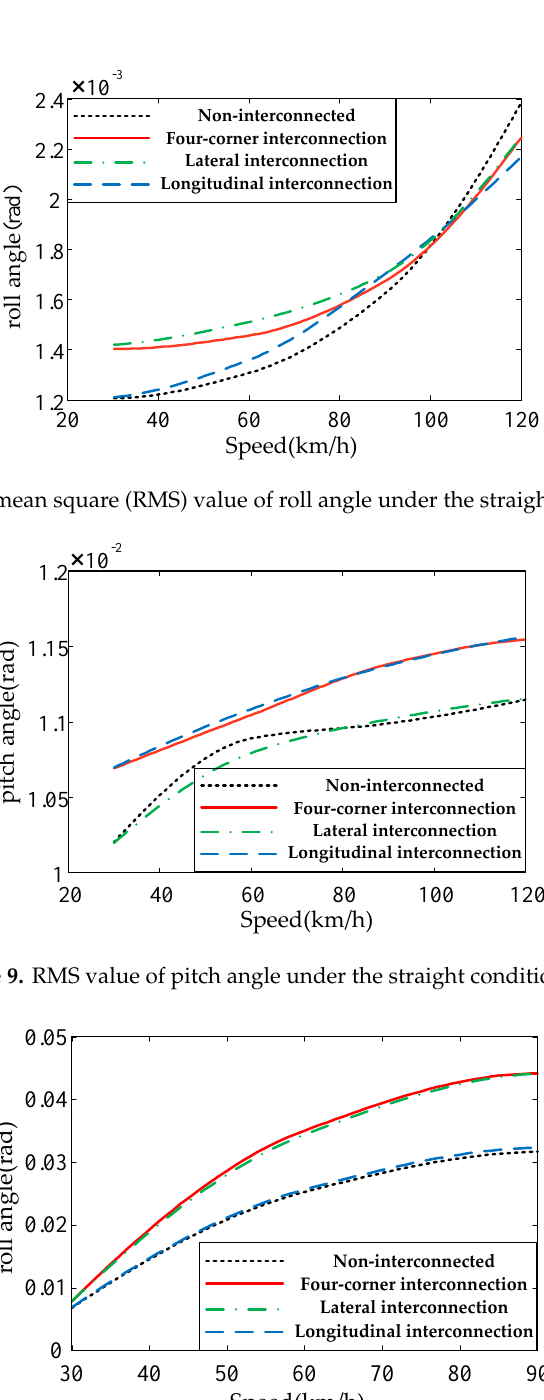
Figure 11. RMS value of pitch angle under the steering condition. Table 1. Control strategy of air suspension interconnection modes. Vehicle Driving Mod